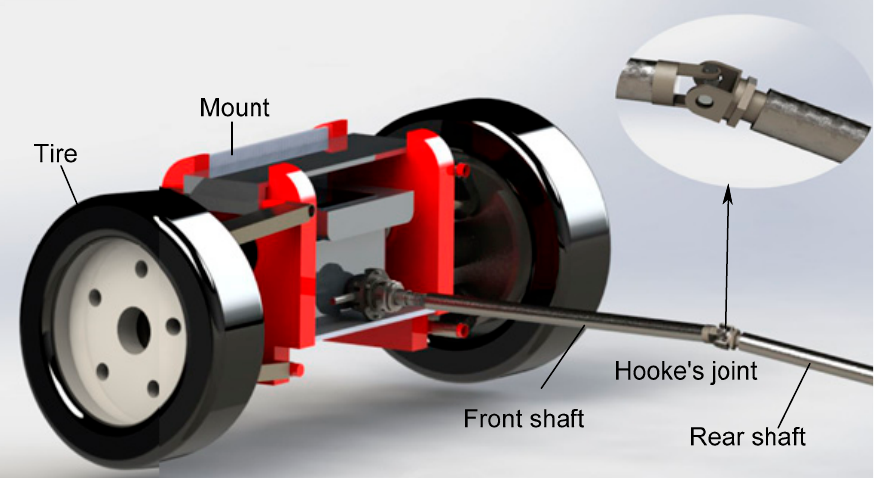
Figure 1. Illustration of a vehicle with two propeller shafts interconnected by a single Hooke’s joint.